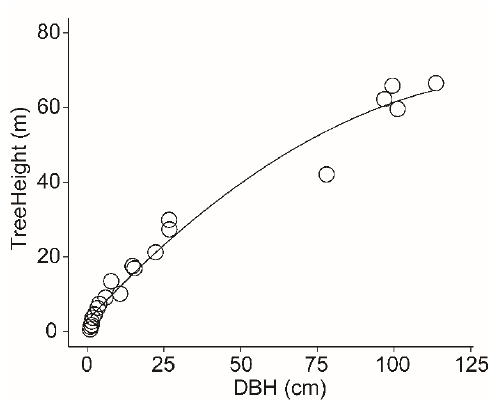
Figure 2. Relationship between tree height and diameter at breast height (DBH) of P. chinensis. The curve indicates the quadratic regression result.